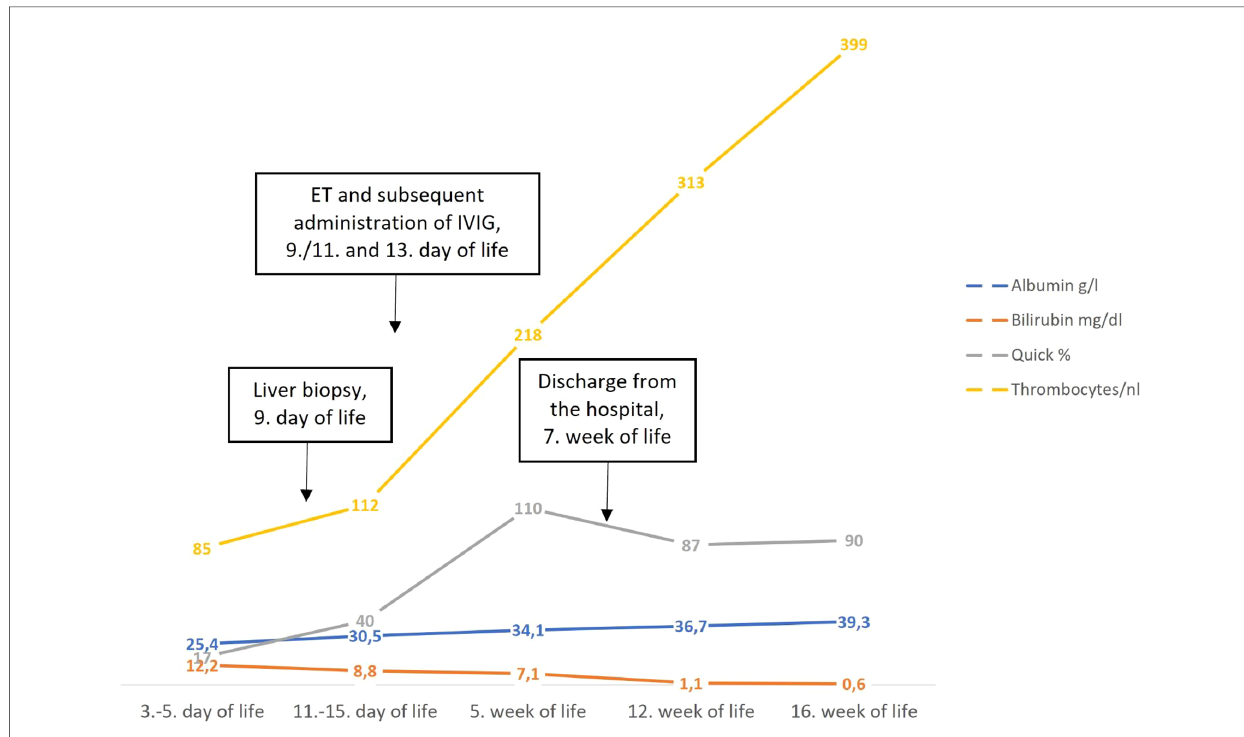
FIGURE 2 Normalization of laboratory fi ndings after therapy. Supplementation of vitamin K was discontinued after 4 weeks. ET, exchange transfusion, IVIG, intravenous